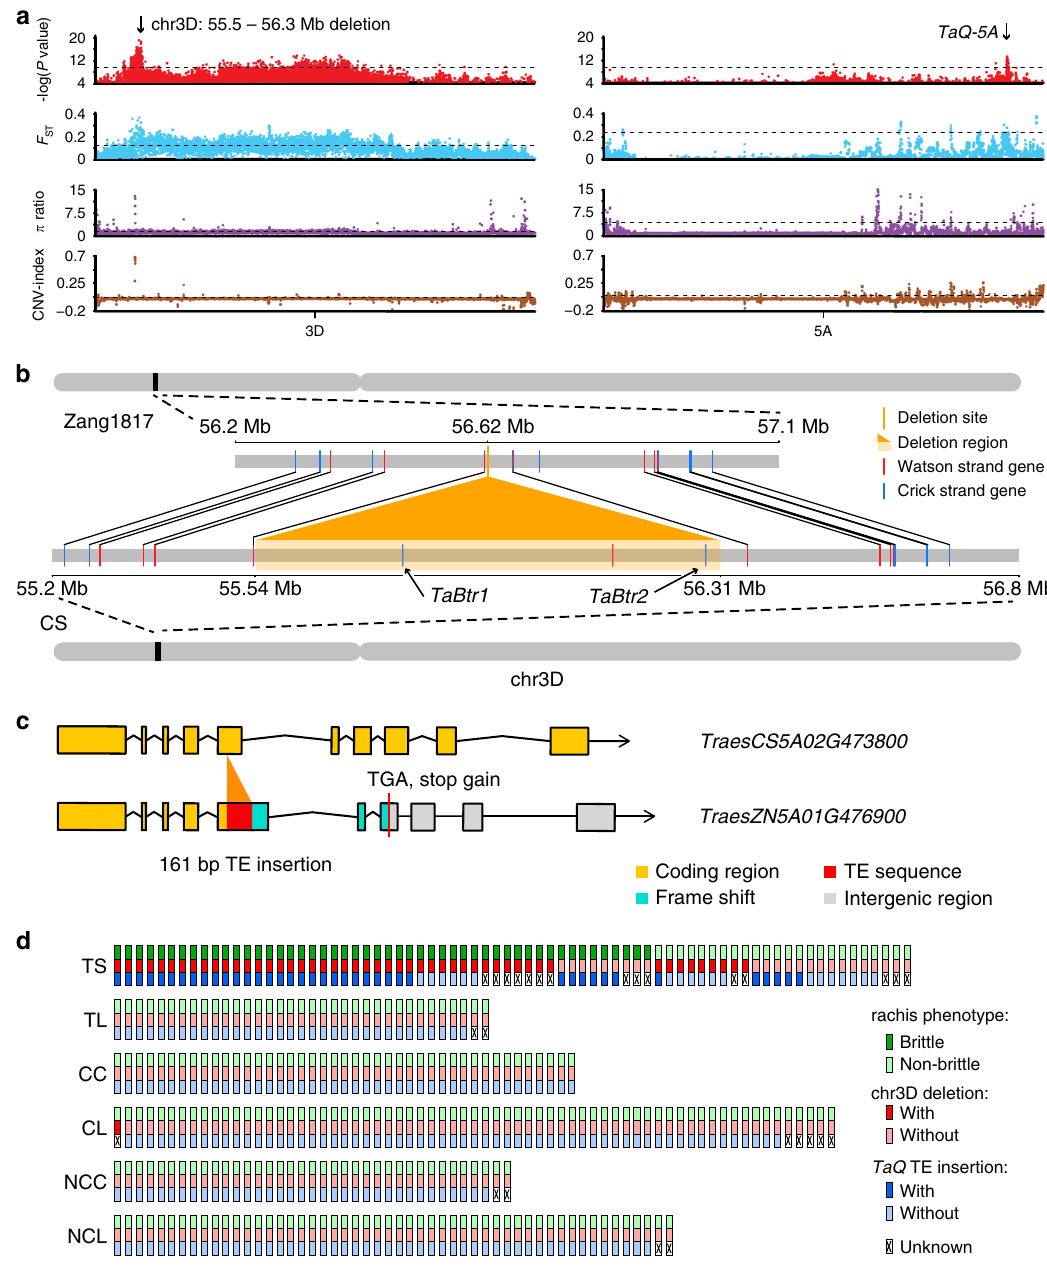
Fig. 4 Genomic differentiation during de-domestication process. a Genome-wide scanning of candidate regions for rachis brittleness during wheat de- domestication process using GWAS analysis. Dashed lines represent the top 5% thresholds. Two signi fi cant divergent regions (0.8-Mb genomic region in chr3D and TaQ-5A ) are labeled above the dot peaks. b Genomic structure comparison of 0.8-Mb genomic region with signi fi cant divergence between the Zang1817 assembly (upper panel) and CS reference genome (lower panel). BRITTLE RACHIS -LIKE gene potentially related to rachis brittleness locates in the region. Collinearity of high-con fi dence genes between two genomes were shown in lines. Dashed line indicates un-annotated genes although with intact genomic sequence. c Genomic comparison of TaQ-5A between Zang1817 and CS genomes. A 161 bp TE insertion (red) was identi fi ed in Zang1817, resulting in frame-shift variation and gain of stop codon (red line). d Schematic diagram of genomic variations and phenotype alterations related to wheat rachis brittleness. Source data underlying Fig. 4a are provided as a Source Data fi